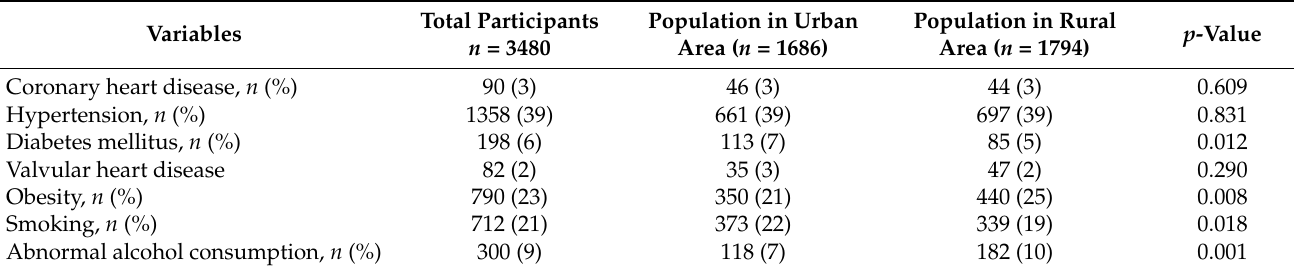
Table 3. Risk factors for HF according to the main administrative